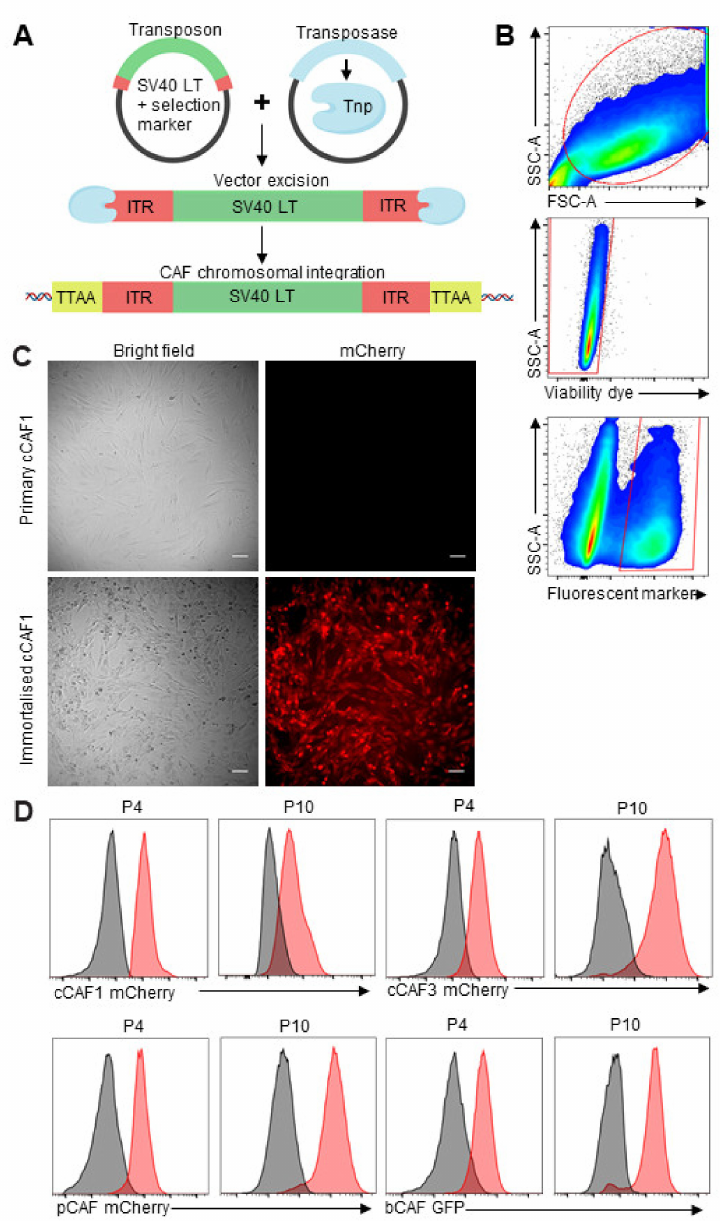
Figure 1. Generation of immortalized cancer associated fibroblasts (Im-CAFs). ( A ). The simian virus 40 large T (SV40LT) antigen + green fluorescent protein (GFP)/or mCherry expression plasmid was co-transfected into primary CAFs with the transposase expression plasmid. Once inside the cell, the transposase (Tnp, blue) is expressed and recognizes the inverted terminal repeat (ITR, red) sequences flanking the SV40LT and fluorescent marker sequences. The transposase excises the gene of interest, fluorescent marker and flanking ITR sequences from the expression plasmid and integrates it randomly into TTAA recognition sites throughout the genome (yellow). ( B ). Transfected CAFs were sorted by fluorescent selection marker using fluorescence activated cell sorting (FACS). bCAF sample shown; representative of 4 cell lines. ( C ). Brightfield and immunofluorescence of primary and immortalized cCAF1 cell lines. Scale bar is 100 µ m. ( D ). Expression of mCherry and GFP in immortalized CAFs at different passages. P = passage number. Red = transfected, grey =